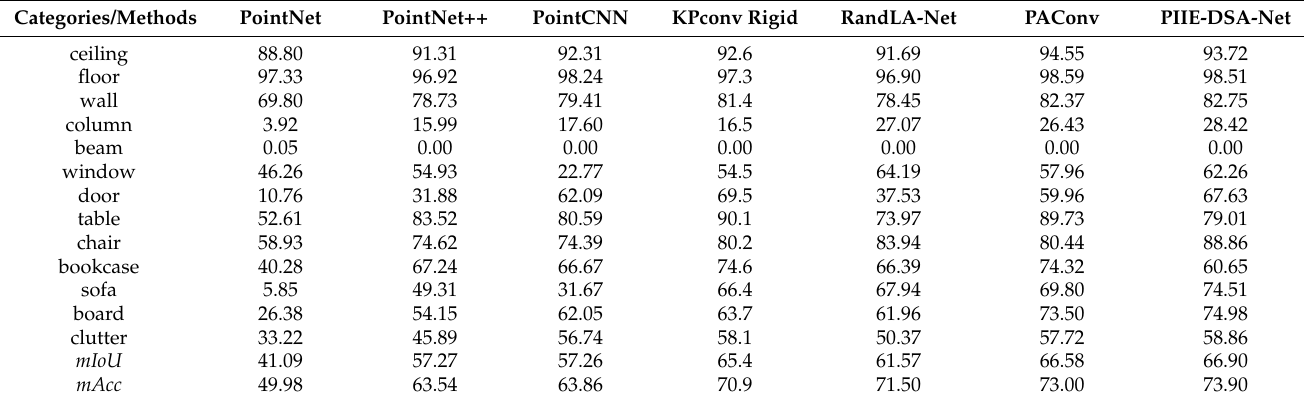
Table 3. The Area5 experiments on the S3DIS dataset (%).